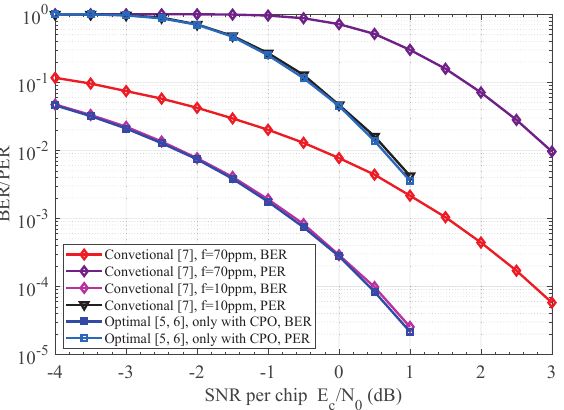
Figure 10. BER and PER performances of [8] versus two particular CFOs. CFO: carrier frequency offset.